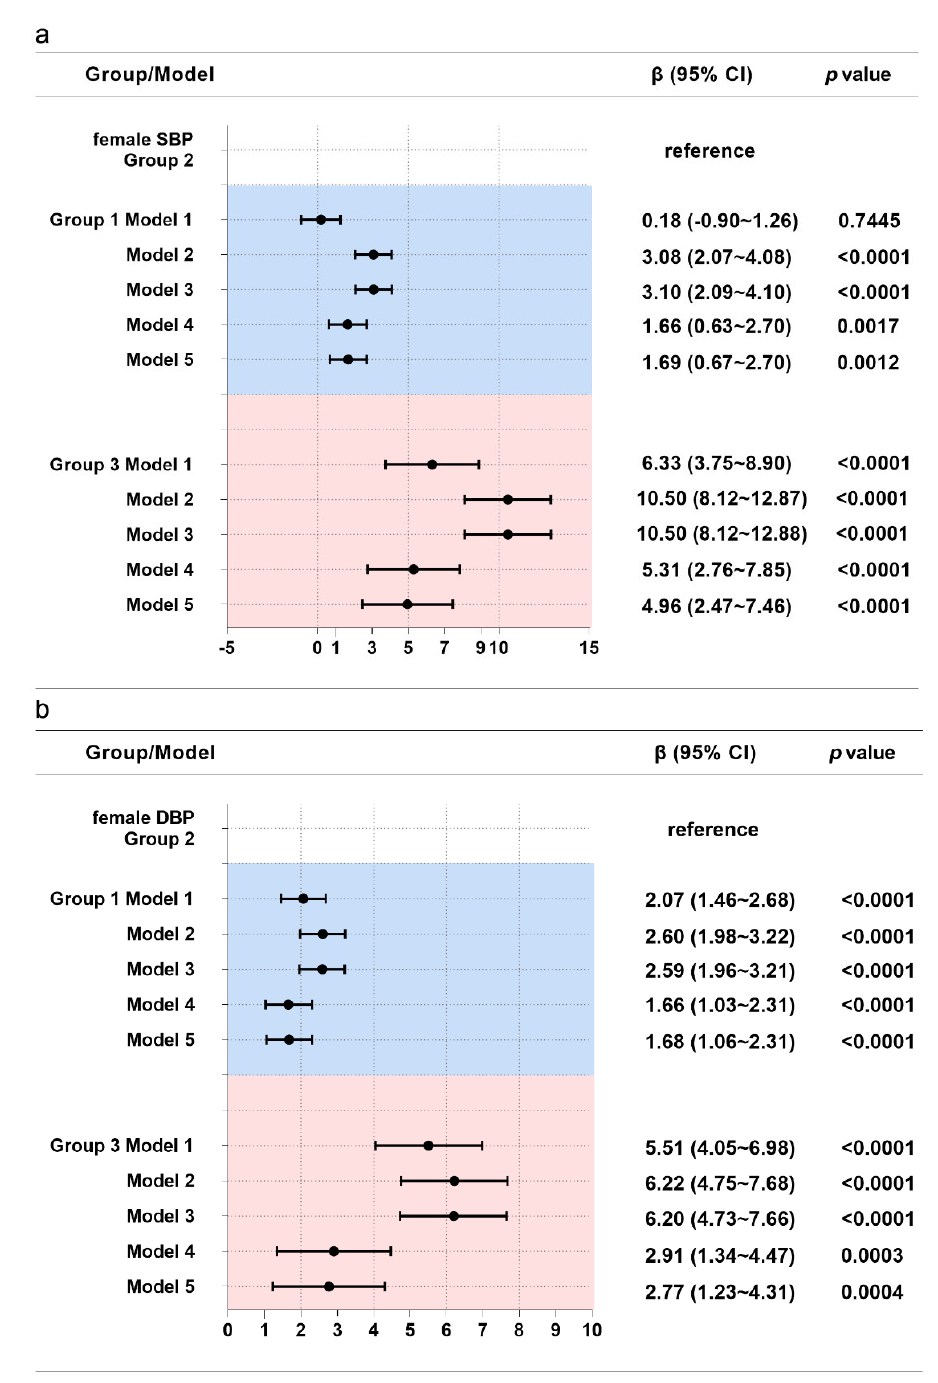
Figure 3. Associations between WC trajectories and SBP ( a ) and DBP ( b ) in females. Note: Model 1 adjusted for no covariates. Model 2 adjusted for age, educational level, geographic region (urban or rural), annual household income per capita, survey year, and follow-up time. Model 3 additionally adjusted for physical activity, current smoking status, current drinking status, Na intake, and K intake. Model 4 additionally adjusted for BMI and WC. Model 5 additionally adjusted for SBP and DBP.